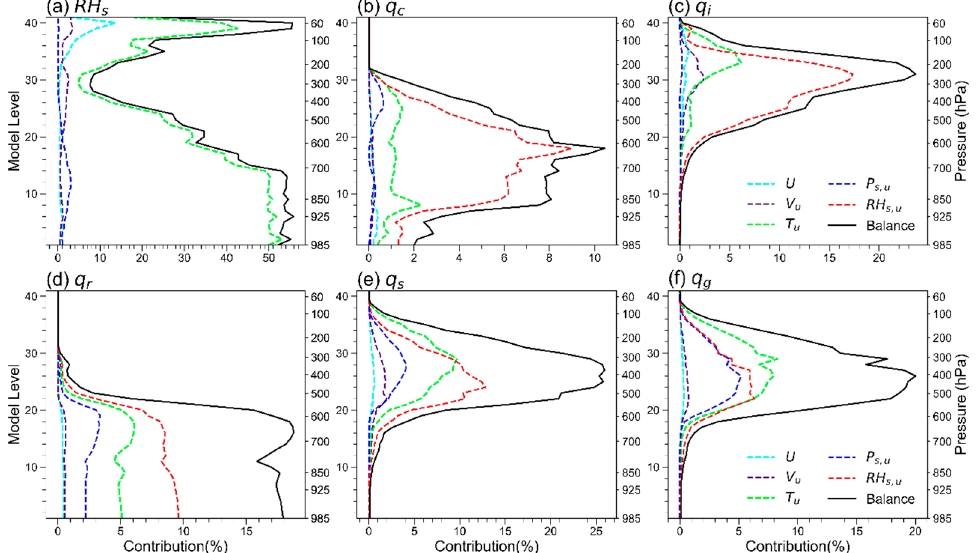
Figure 2. Vertical distribution of the balance part contribution to ( a ) RH s , ( b ) q c , ( c ) q i , ( d ) q r , ( e ) q s and ( f ) q g . The “Balance” line is the sum of others, and the larger the contribution, the stronger the correlation between the two CVs.